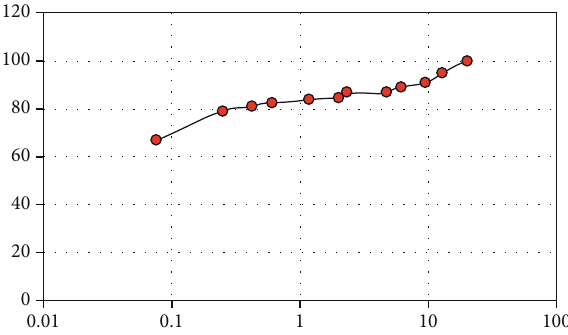
Figure 3: Gradation curves of course aggregate.